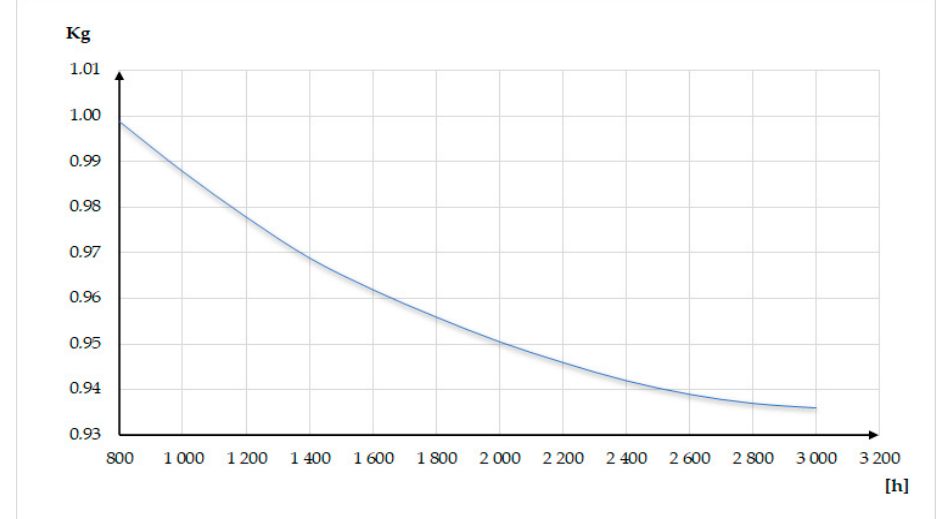
Figure 13. Graph of the reliability of wind farm devices in the operation process as a function of the